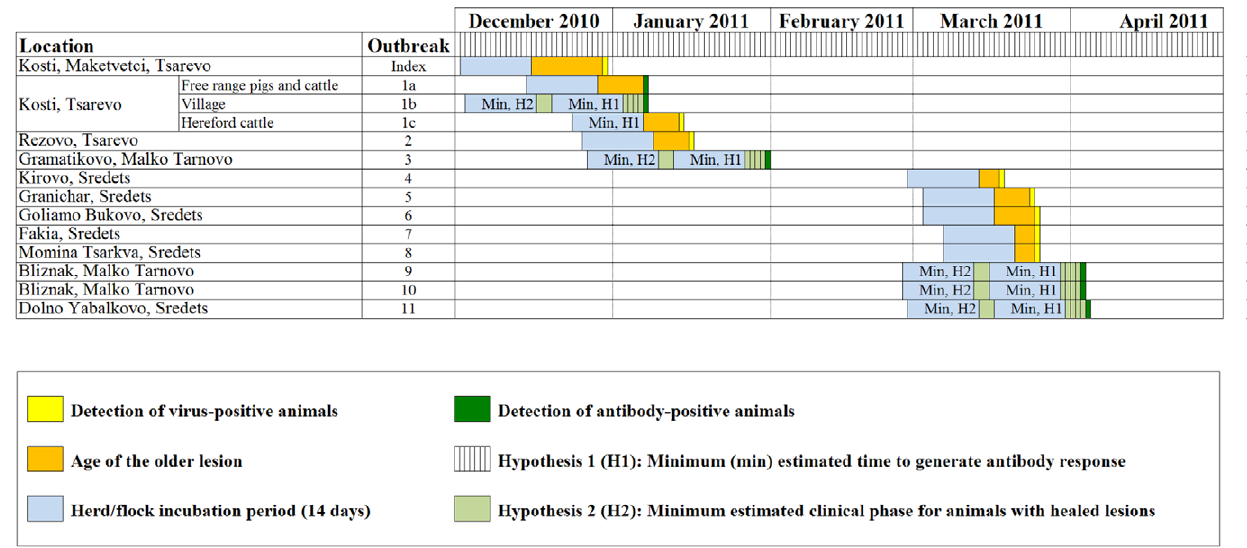
Figure 6. Estimated time in which FMDV might have been introduced causing the different Bulgarian outbreaks. This illustration was built according to the date of sample collection, the virus and serological results of the collected samples and the age of the lesions of the animals with clinical signs. The date of sample collection is coloured in yellow in case of the virus-positive outbreaks, and in dark green in case of the seropositive-only outbreaks. The age of the lesions of the animals with clinical signs (if any), according to the National Veterinary surgeons involved in the outbreaks, is coloured in orange. The incubation time, estimated to be 14 days, is coloured in blue. In the case of the seropositive-only outbreaks, two different times were considered to explain the presence of antibody-positive/virus-negative samples, depending on whether clinical signs where unobserved or mild (hypothesis 1, H1) or whether the lesions had healed (H2). In case of H1, a minimum of 5 days post-infection was estimated (shaded with vertical stripes), whereas a minimum of 21 days post-infection for H2 (pale green). All estimated times were based on previous studies [1,9]. Only genetic data can prove a link between waves one and two.